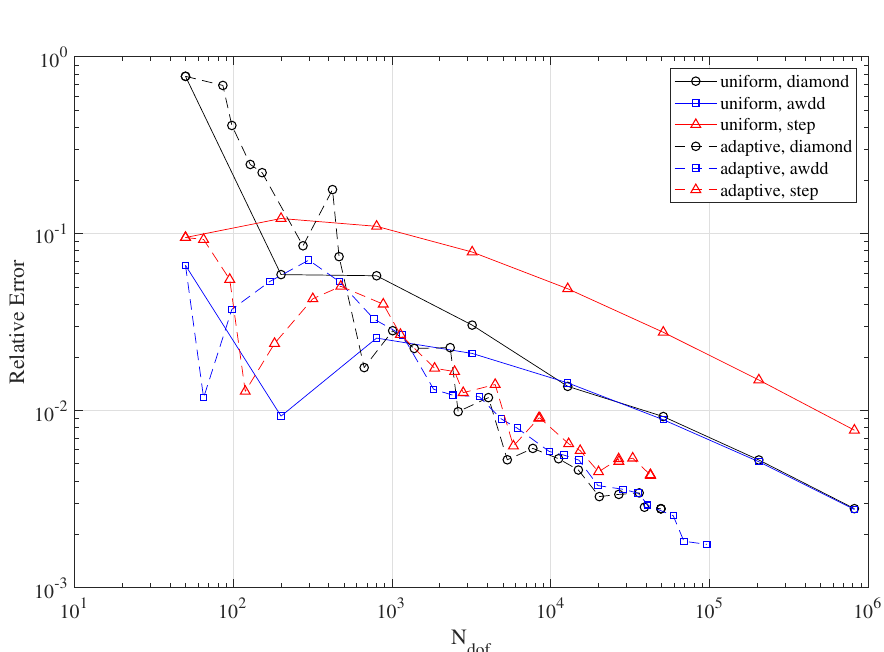
Figure 6: Convergence of the average flux in Region (IV) using uniform and adaptive h -refinement.